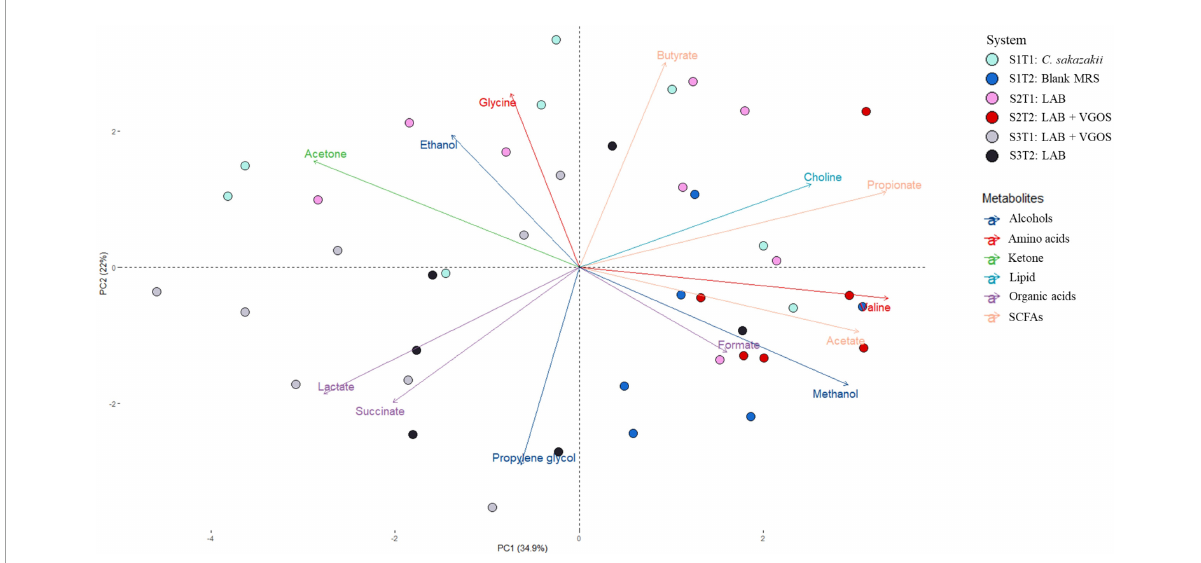
FIGURE4 Principal Component Analysis (PCA) biplot of metabolite profiles from all SHIMEs across two treatment periods. The labels indicate the SHIME and treatment period. For example, S1T1 indicates that the light blue samples are for the first treatment period of SHIME 1. Each SHIME is represented by a different color and treatment periods are differentiated by the shade of the color, i.e., light or dark shade.